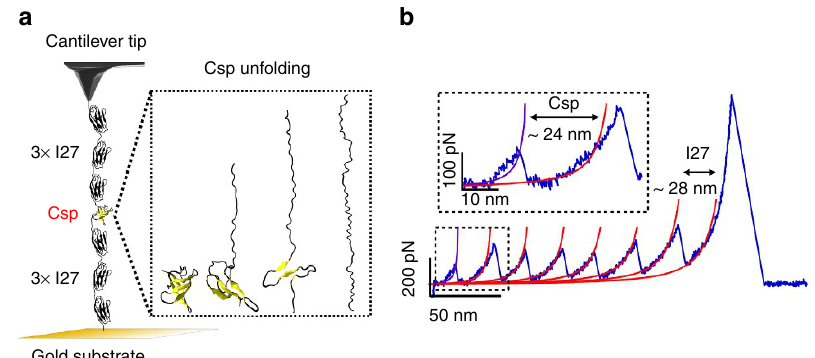
Figure 1 | Mechanical extension of Csp. ( a ) Schematic of the (I27) 3 - Csp-(I27) 3 polyprotein construct used in our experiments placed between a cantilever tip and the gold surface. The movement of the piezoelectric actuator allows the application of force to the polyprotein and thus investigate Csp mechanical unfolding. ( b ) A typical force-extension curve of the polyprotein